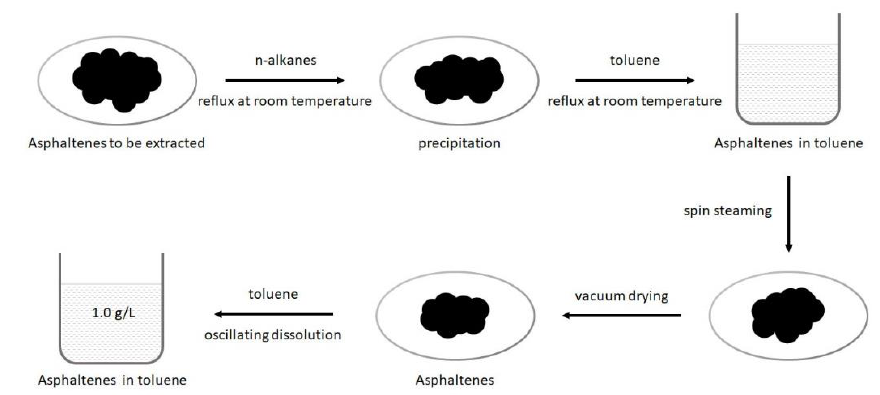
Figure 4. Schematic diagram of the asphaltenes extraction process.